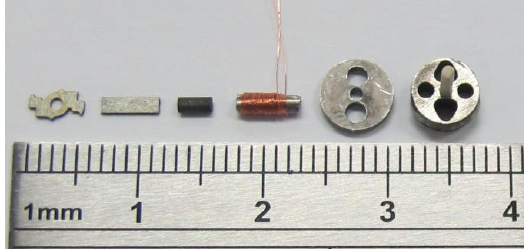
Figure 15. Mechanical parts of the axial-flux, single-phase switched reluctance motor.